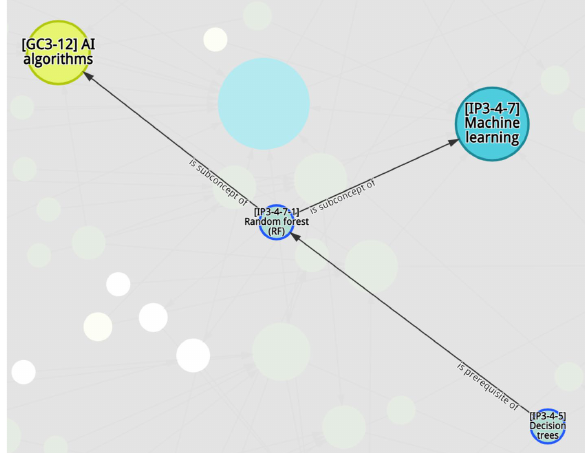
Figure 7 . Indirect relationship of Decision trees concept with concepts from AI